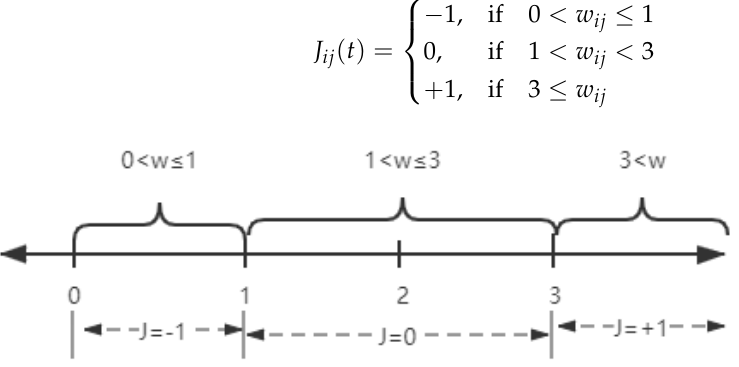
Figure 3. Mapping of weights and